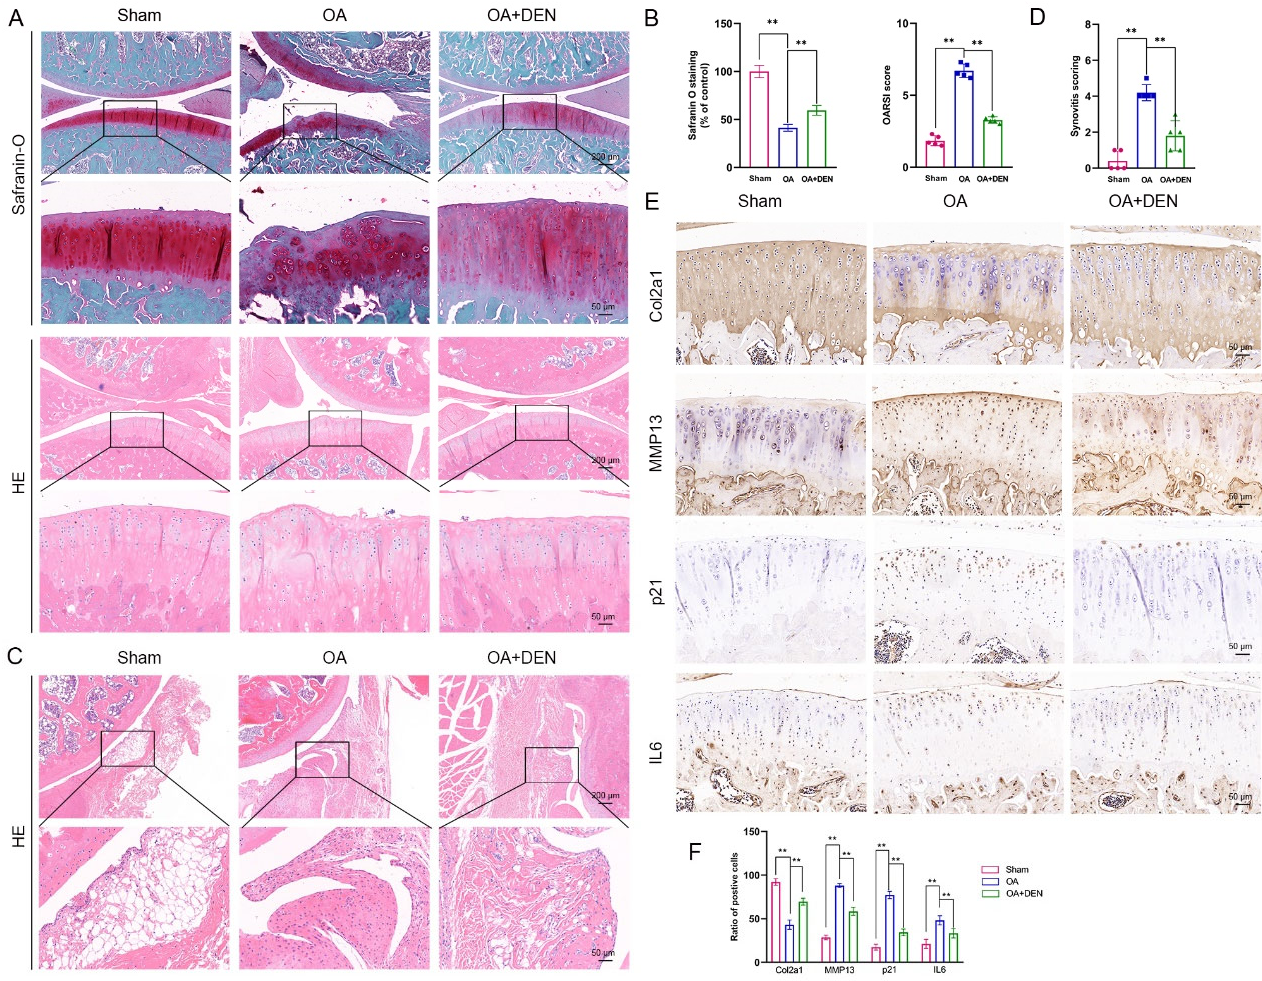
Figure 8. Histological evaluation of dendrobine (DEN) on the progression of osteoarthritis (OA) in a rat model of OA. ( A , B ) Morphology of cartilage shown in Safranin O staining and HE staining and the Osteoarthritis Research Society International (OASRI) score, n = 5. ( C , D ) HE staining of synovium and synovitis score. ( E , F ) Immunohistochemical staining assay of Col2a1, MMP13, p21, and IL6 in the cartilage, n = 3. The values presented are the means ± SD. ** p < 0.01.